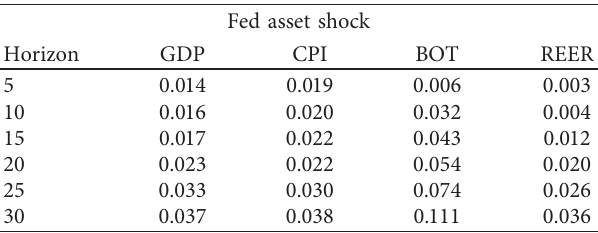
Table 6: The variance decomposition to fed asset shock.